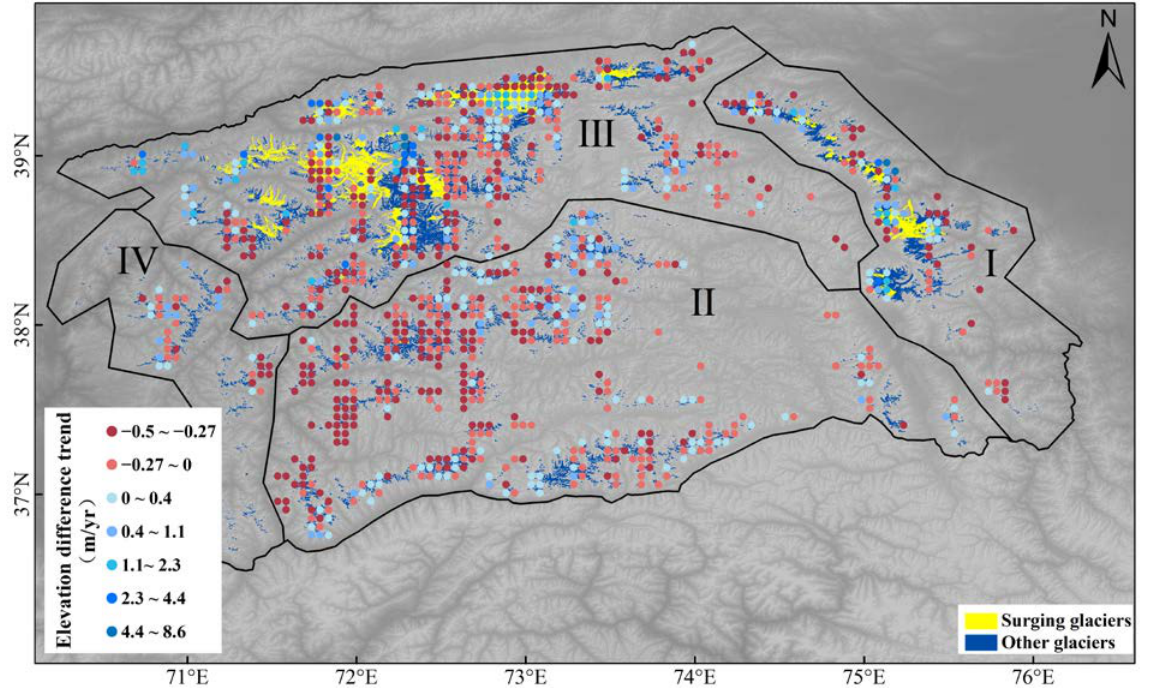
Figure 9. Spatial interannual variation in the GSE in the Pamir. Overview of the surging glaciers identified by the yellow glacier boundaries. The surging glacier data source is from Goerlich, Bolch, Paul (2020): More dynamic than expected: an updated survey of surging glaciers in the Pamir.